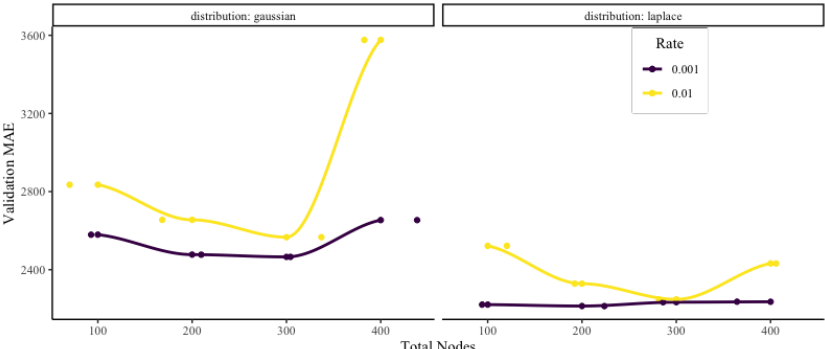
Figure 19. Visualization of the results from tuning deep learning models to predict severity on the COLL data. Validation MAE is shown as a function of the total nodes in the neural network, with each pane showing a different distributional assumption of the network and each line representing a different learning